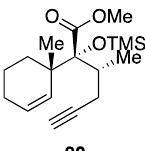
Figure 2. Structure of building block 20 .